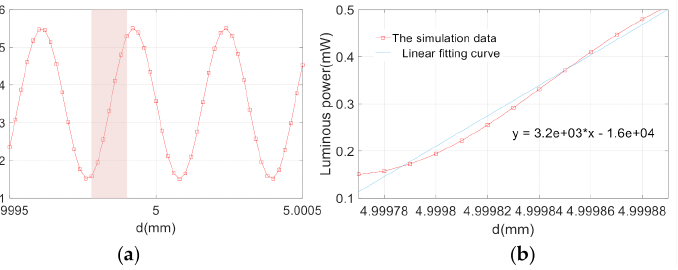
Figure 6. ( a ) Displacement-intensity curve for the +1 level. ( b ) Fitting of displacement-intensity magnification curve for the +1